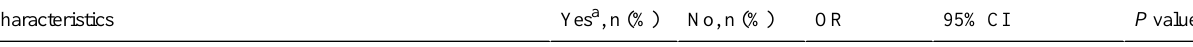
During intervention